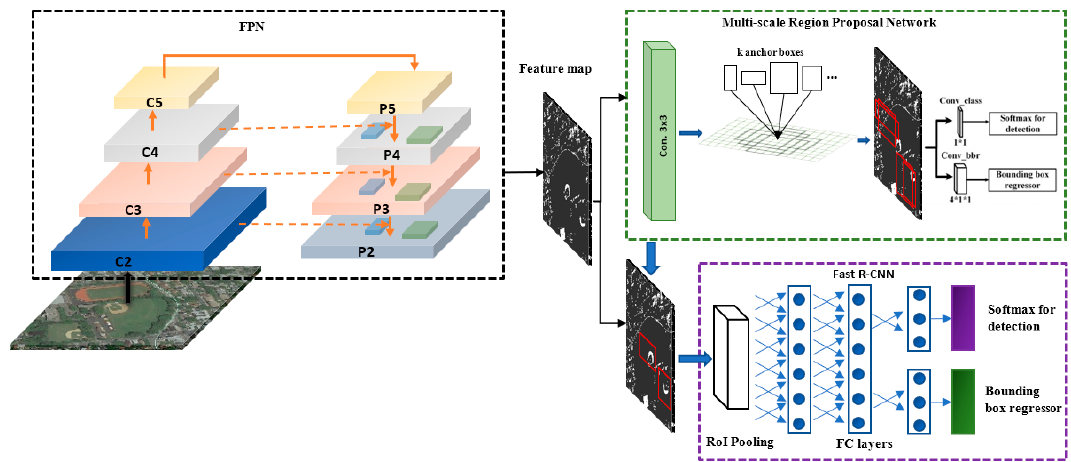
Figure 9. Feature pyramid networks (FPN) is feature extraction with multi-scale region proposal network (RPN) and is the architecture of the first training experiment.